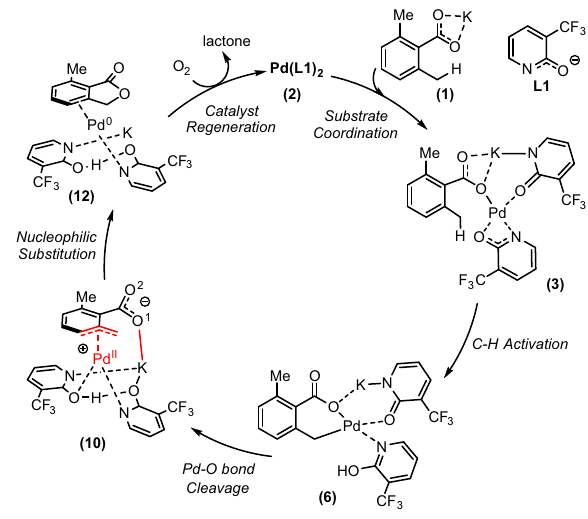
Fig. 8 The proposed mechanism. The mechanism of the C(sp 3 ) – H lactonization in aromatic 2,6-dimethyl benzoic